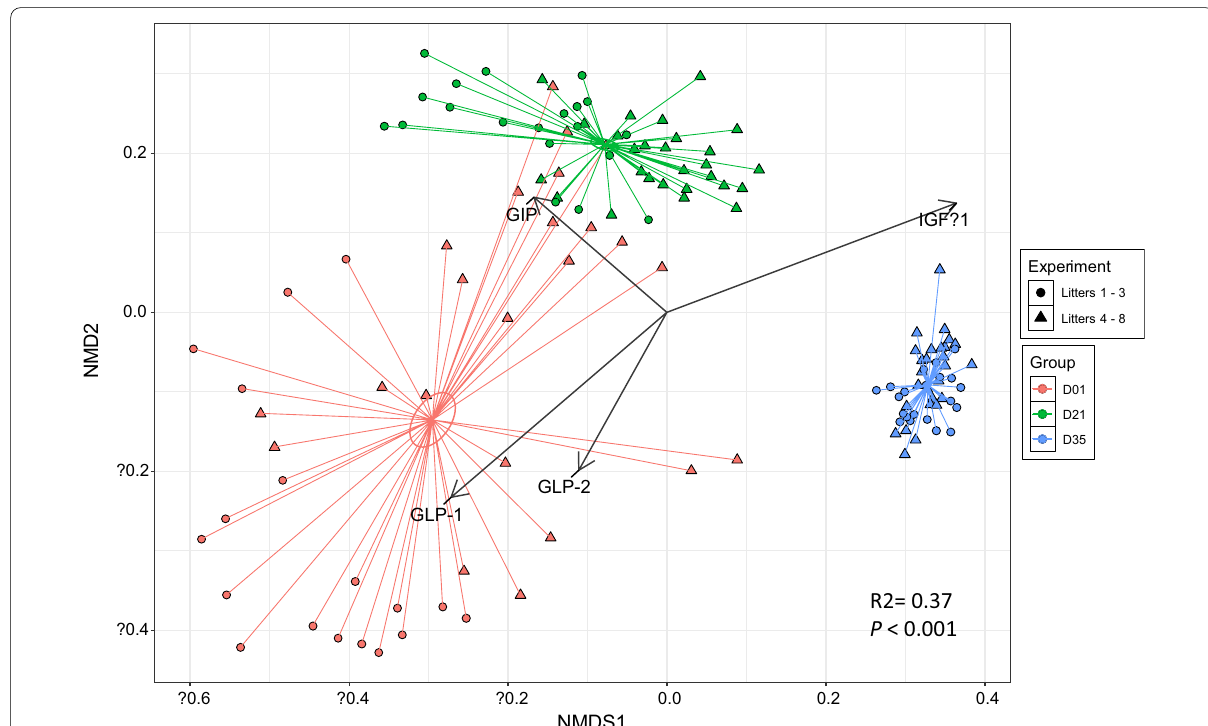
Fig. 4 Non-metric multidimensional scaling (NMDS) plot of the piglet fecal community structure at different time points based on Bray–Curtis dissimilarity matrix. Legend: The effect of age on community was tested using permutational analysis of variance (PERMANOVA). The envfit function was used to fit peptide variables to the ordination plot. Ellipses indicate 1 standard error from centroid. Arrow lengths are scaled at 0.5. Only peptides that showed significant correlation ( P < 0.05) with the unconstrained ordination axes were